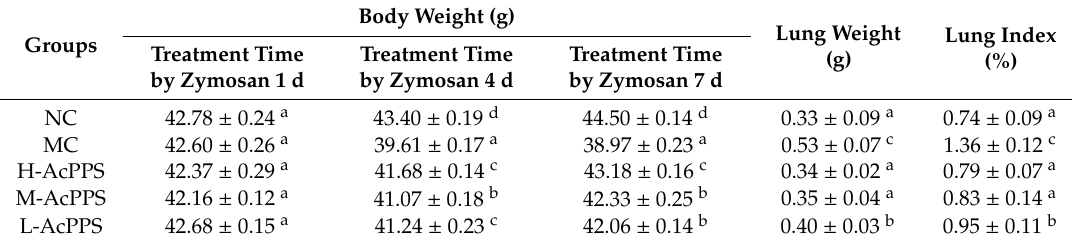
Table 1. Body weight, lung weight, and lung index of all mice after zymosan-infection.